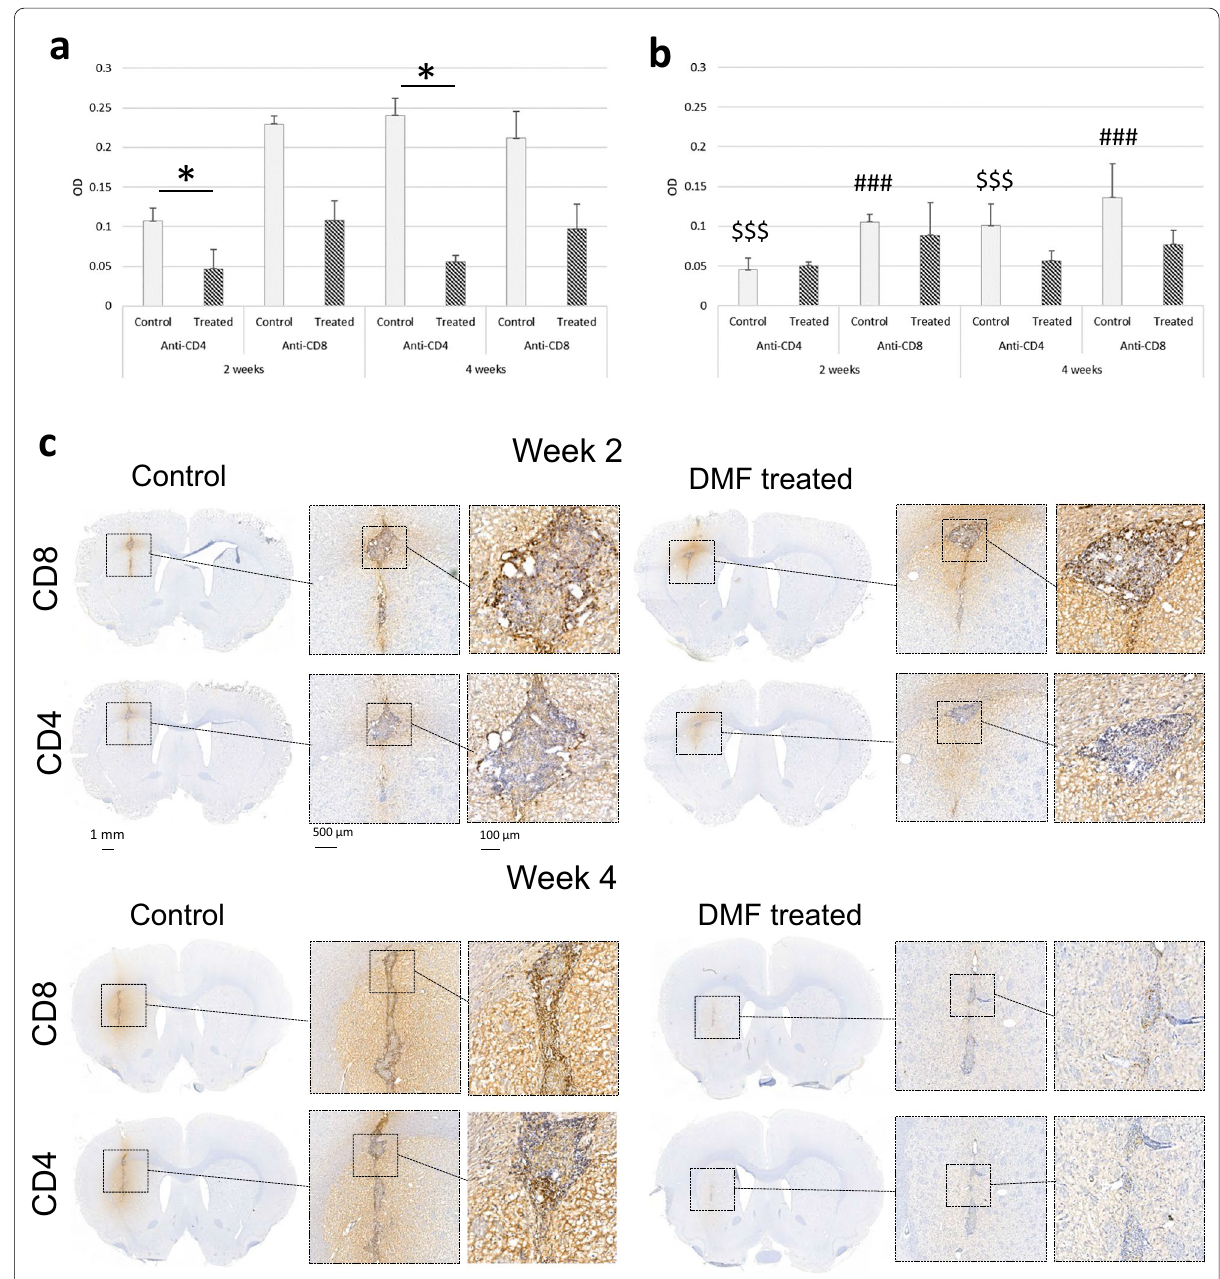
Fig. 5 Immunohistochemical staining of T lymphocytes. Staining was performed against CD4 and CD8 for control and DMF‑treated animals in Set B ( n 8) and Set C ( n 8) 2 and 4 weeks after treatment with vehicle or DMF. Optical density (OD) was calculated by subtracting the contralateral = = OD ROI from the lesion/perilesional OD ROI . a The OD of CD4 + and CD8 + T lymphocytes at the lesion core. The asterisk (*) denotes significant differences between DMF‑treated and control animals. b The corresponding OD in the perilesional area. In both the anti‑CD4 and anti‑CD8 staining, the control group had significantly higher OD values at the lesion core ( a ) than in the perilesional area ( b ) ( p < 0.001). These differences were not found in the treated group (anti‑CD4: p 1; anti‑CD8 p 0.2) in post hoc analysis. Controls had significantly higher CD4 + OD values at the lesion = = core ( a ) compared to the DMF‑treated group ( p 0.041), but this was not detected with CD8. The dollar sign ($) indicates significant differences = between the CD4 + OD of the control animals at the focal lesion core ( a ) compared to the perilesional area ( b ) ( p < 0.001). The number sign (#) indicates significant differences between the CD8 + OD of the control animals at the lesion core ( a ) compared to the perilesional area ( b ) ( p < 0.001). The results are presented as mean (SD). c Representative immunohistochemical staining against CD4 + and CD8 + T lymphocytes in the lesion core in the control and DMF‑treated animals. Nuclei are counterstained with haematoxylin. Scale bar 500 µm, or 100 µm in the enlarged =